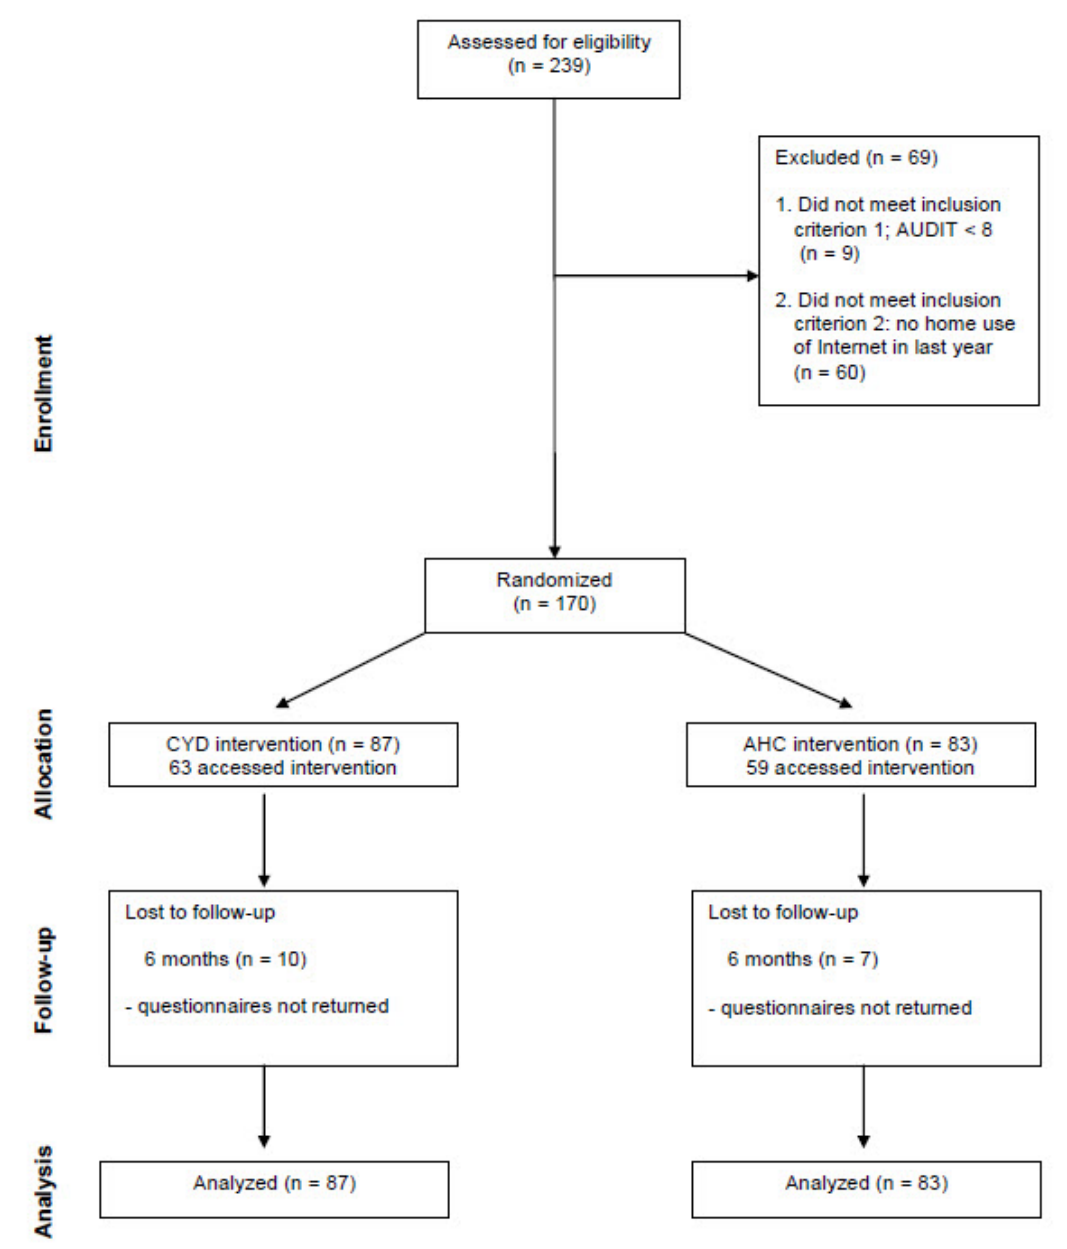
Figure 1. CONSORT diagram of participant recruitment. AHC = Alcohol Help Center, AUDIT = Alcohol Use Disorders Identification Test-C, CYD = Check Your